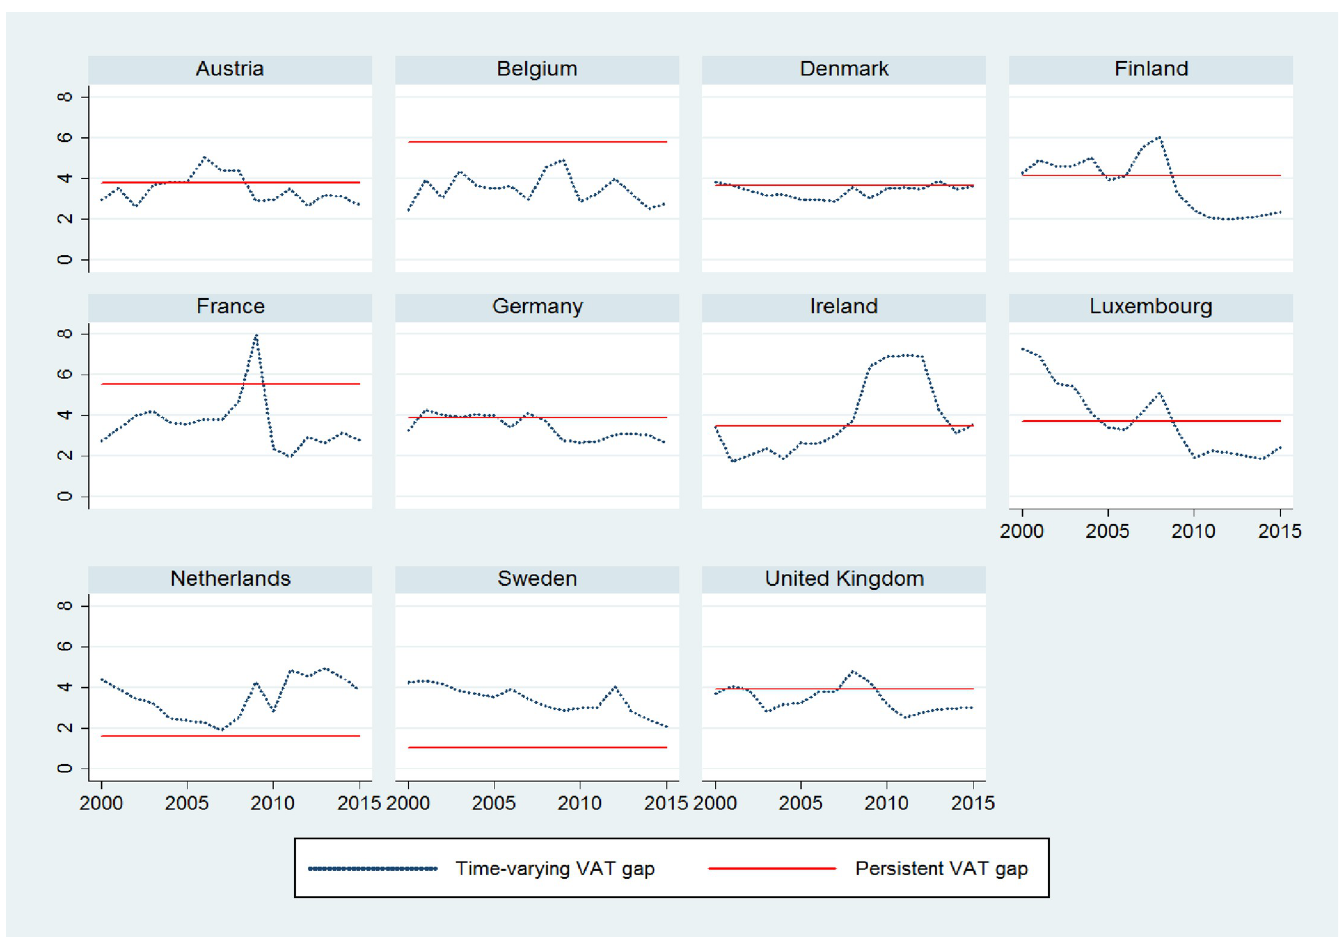
Fig 1. Time-varying VAT gap and persistent VAT gap in the western group of EU countries. The blue dotted line represents the time-dependent Value Added Tax gap and the red line represents the country-specific or persistent Value Added Tax gap, between 2005–2015. The persistent and time-dependent VAT gap was generated in STATA after the STFM